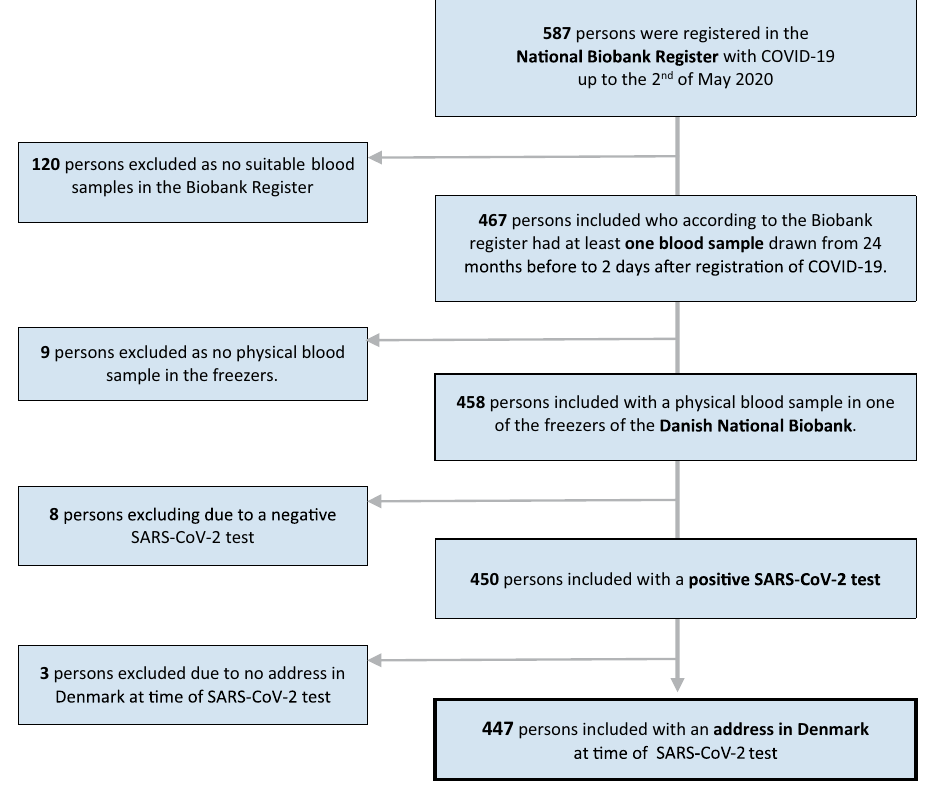
Figure 1. Flowchart showing the identification of the study